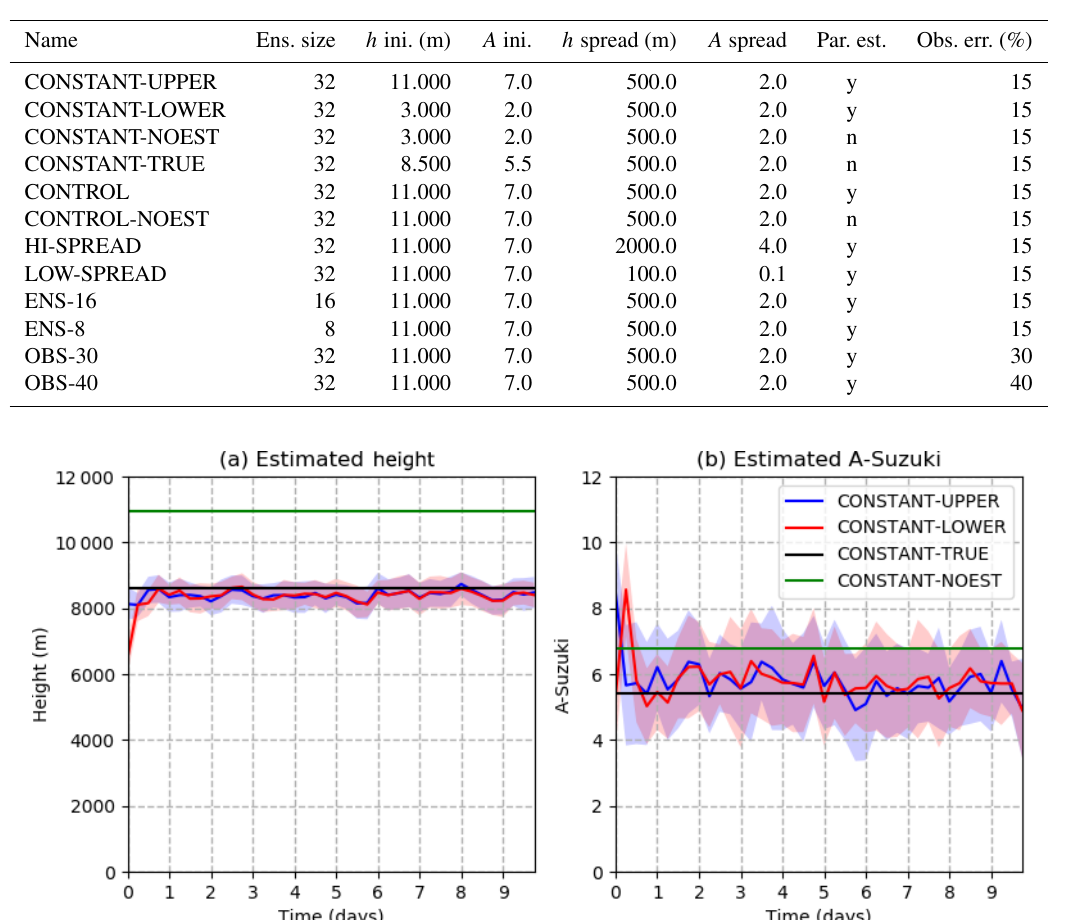
Figure 6. Optimized parameters as a function of time in the CONSTANT-UPPER (blue line), CONSTANT-LOWER (red line), CONSTANT- TRUE (black line), and CONSTANT-NOEST (green line) experiments. The shading surrounding the CONSTANT-UPPER and CONSTANT- LOWER estimated values represents ± 1 standard deviation; (a) h parameter and (b) A Suzuki